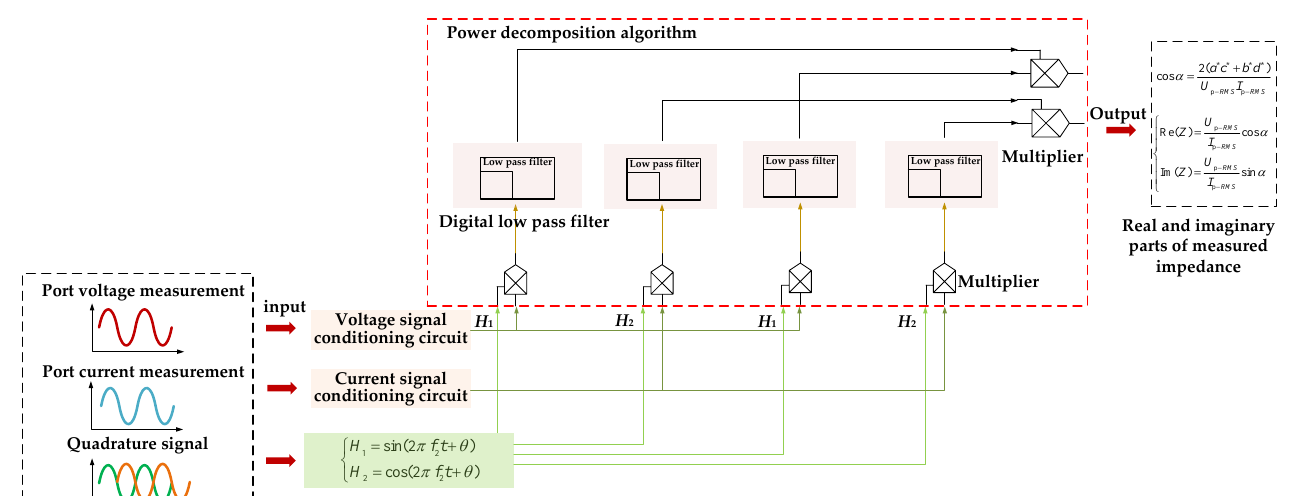
Figure 16. Power decomposition algorithm for measuring port impedance.